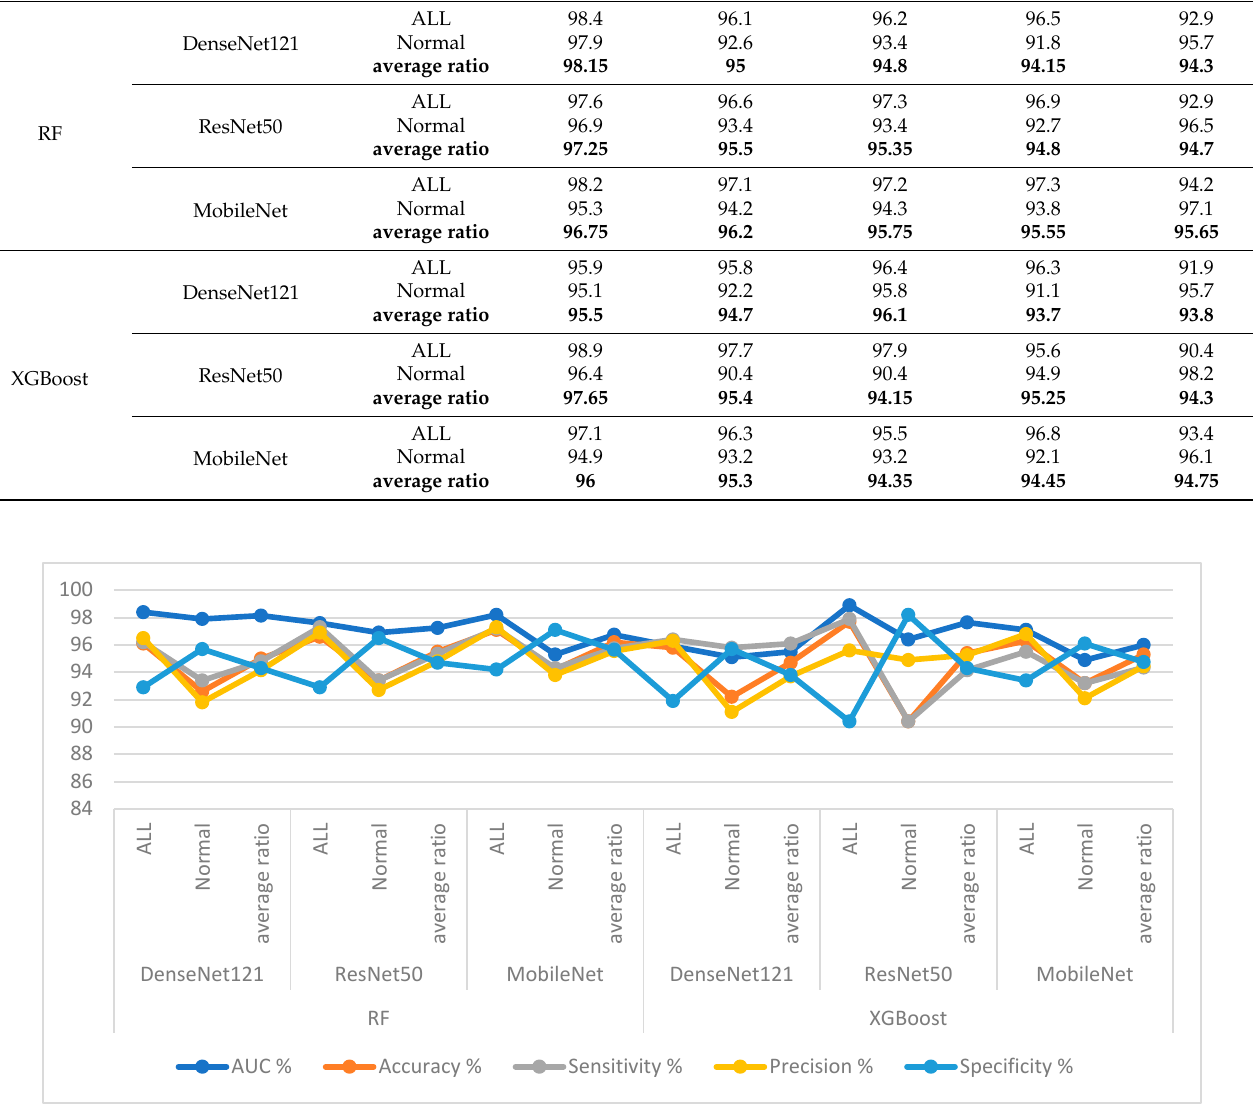
Figure 9. Display of results of the RF and XGBoost classifiers based on the features of the CNN models of the C-NMC 2019 dataset for the diagnosis of acute leukemia. Second, for the ALL-IDB2 dataset, RF and XGBoost classifiers with CNN-fused features achieved promising results. The RF classifier with features of DenseNet121, ResNet50, and MobileNet achieved accuracy, AUC, sensitivity, precision, and specificity of 100%. In contrast, the XGBoost classifier with features of DenseNet121, ResNet50, and MobileNet achieved accuracy, AUC, sensitivity, precision, and specificity of